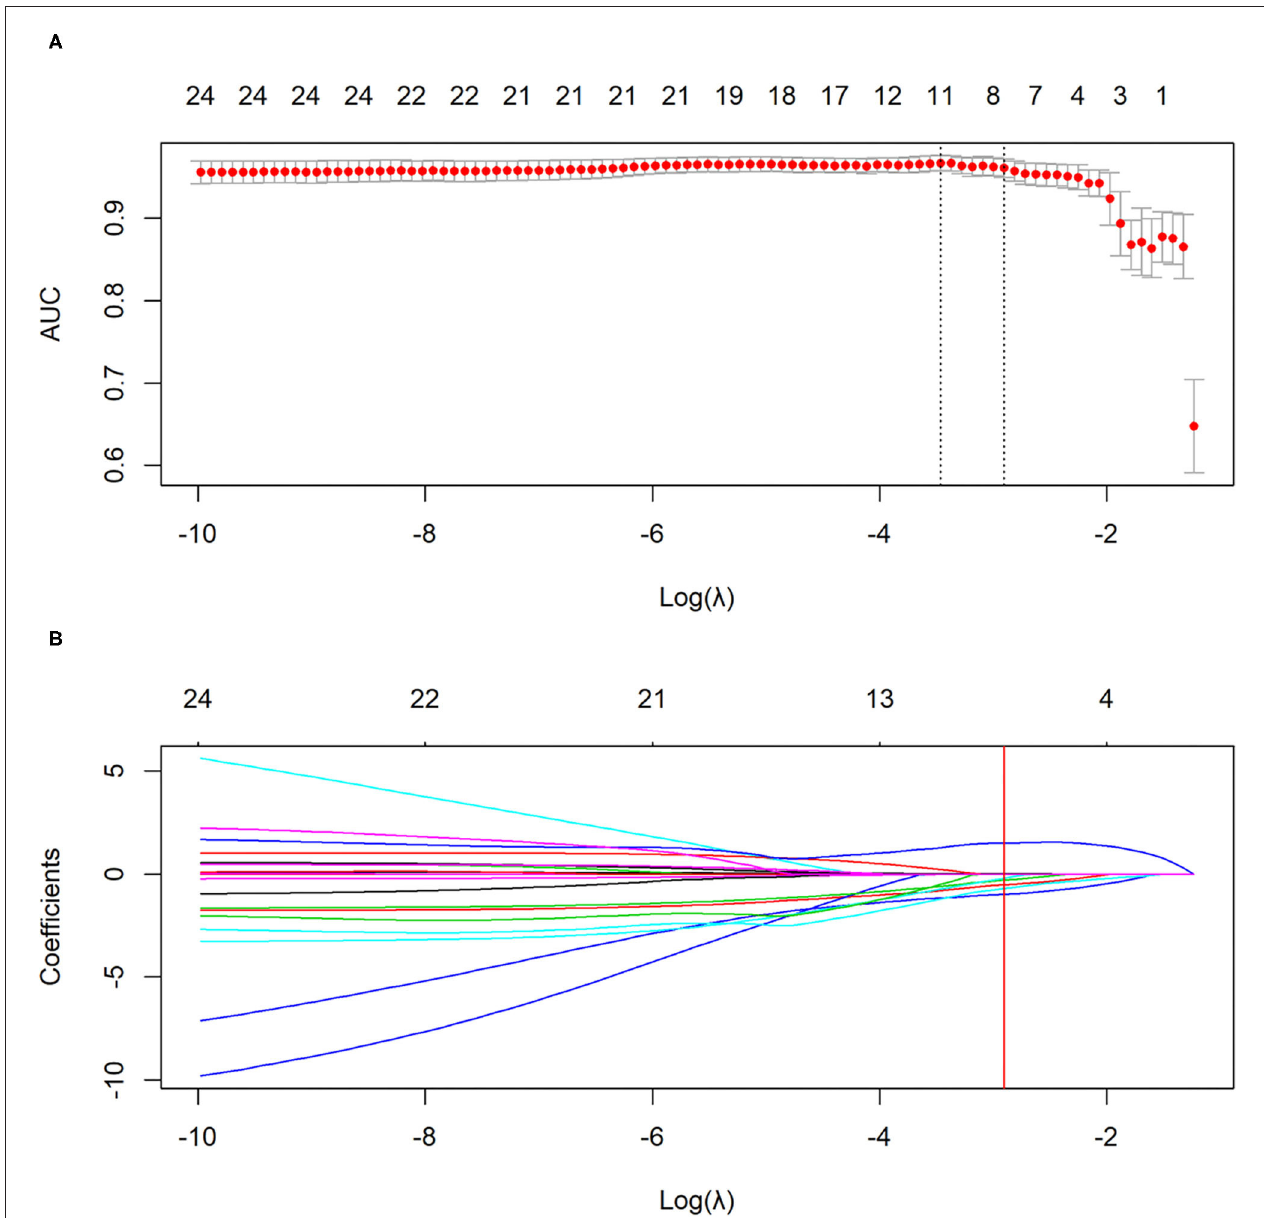
FIGURE 3 | The selection of clinico-radiological features using LASSO logistic regression. (A) Optimal feature selection according to AUC value. (B) LASSO coefficient profiles of the features. Vertical line is drawn at the selected value using 10-fold cross-validation, where optimal λ results in eight non-zero coefficients. LASSO, least absolute shrinkage and selection operator; AUC, area under